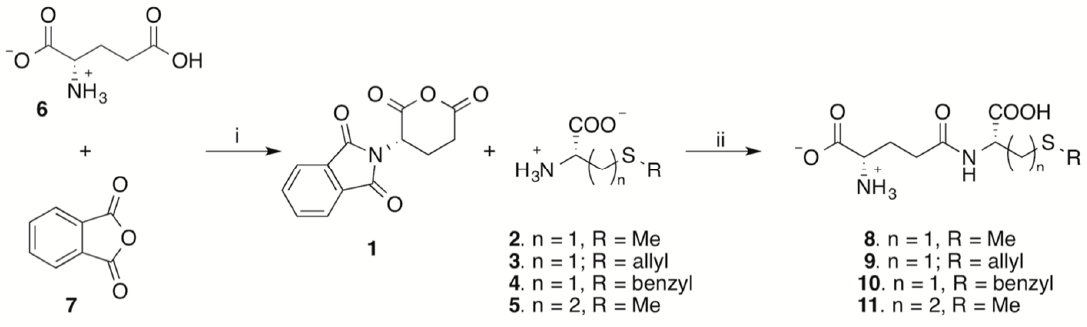
L -cysteine 12. Figure 1. N -phtaloyl- γ -glutamyl- S -methyl- l -cysteine 12